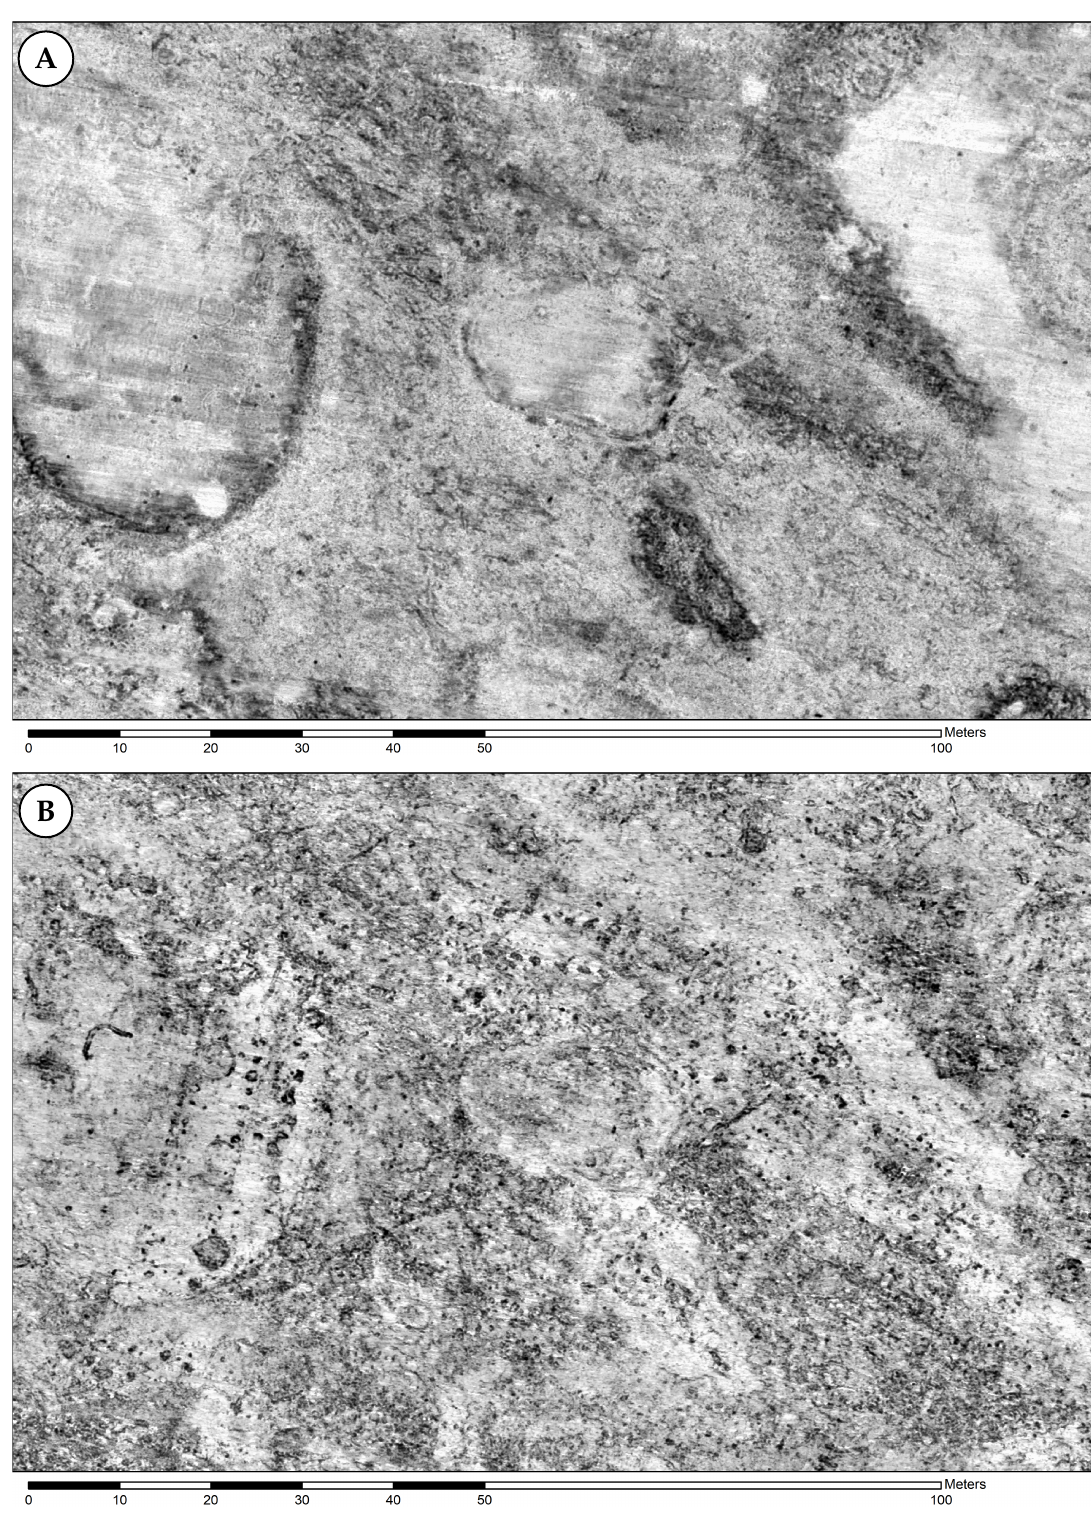
Figure 3. Detail of the same area of the Rysensten GPR data set. ( A ) Conventional GPR amplitude map after Hilbert transformation of the data showing a 5 cm thick depth-slice from approximately 40–45 cm depth. ( B ) Coherence map for the same depth